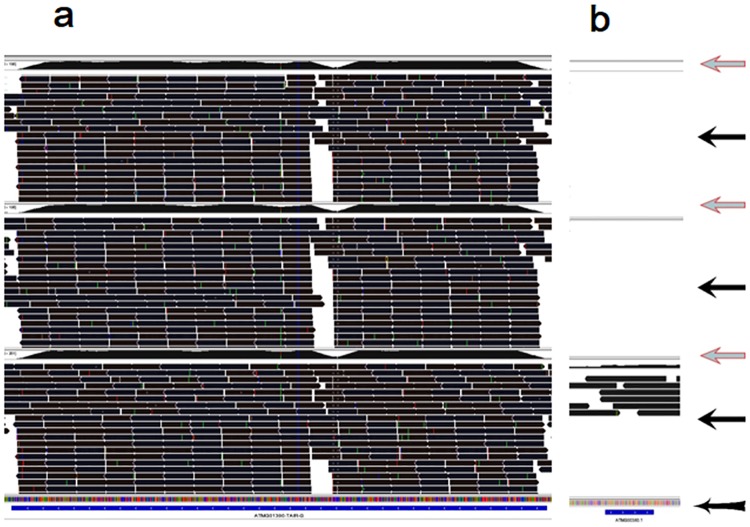
Screenshots from the IGV visualized program present m6A topologies in rRNA and tRNAs in the Arabidopsis mitochondria.Extent of m6A methylation, sequencing depth, sequencing fragment alignment, and gene ID of the sequencing data can be clearly visualized by the IGV program [42]. The area in the screenshot indicated by the arrow, “Red leftwards arrow”, presents m6A methylation extent across the transcript. The area in the screenshot indicated by the arrow, “Black leftwards arrow”, presents sequencing fragment alignment across the transcript. The area in the screenshot indicated by the arrow, “Black leftwards arrow with tail”, presents gene ID information including gene ID, sequence reading direction, the intron and exon regions. (a) The whole rRNA was highly methylated by m6A, representative rRNA, ‘ATMG01390’; (b) The whole tRNA was slightly methylated by m6A, representative tRNA, ‘ATMG00380’, expressed for tRNA-Asn. The Trace files of three organs, leaves (the upper), flowers (in the middle) and roots (the lower) were presented within a screenshot.